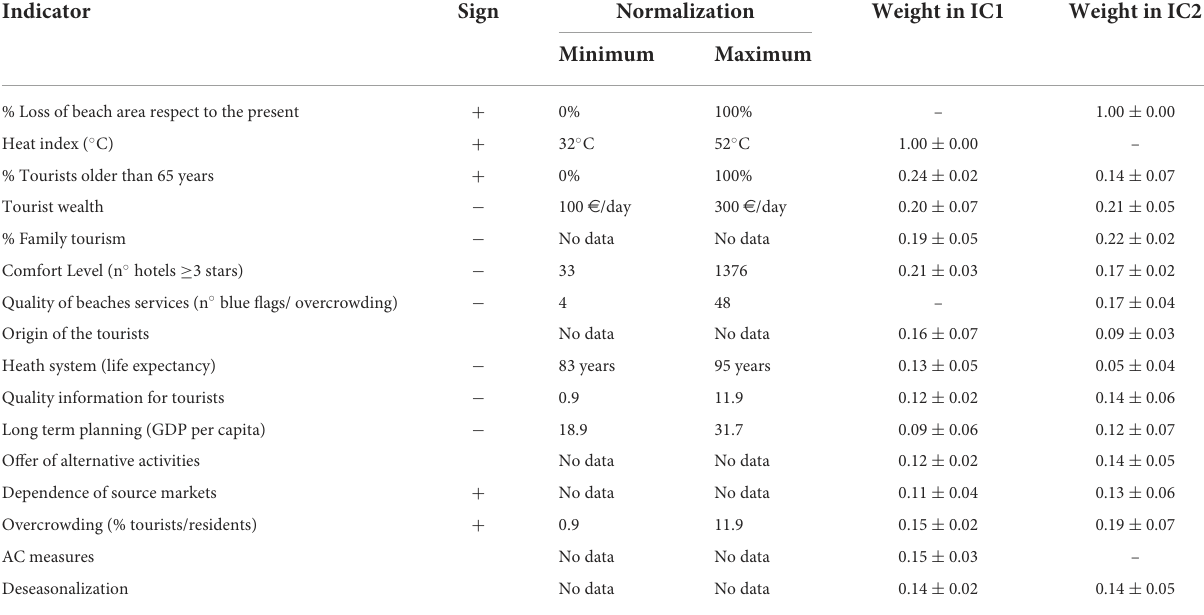
TABLE 2 Normalization thresholds and weights assigned for each indicator in the two ICs.